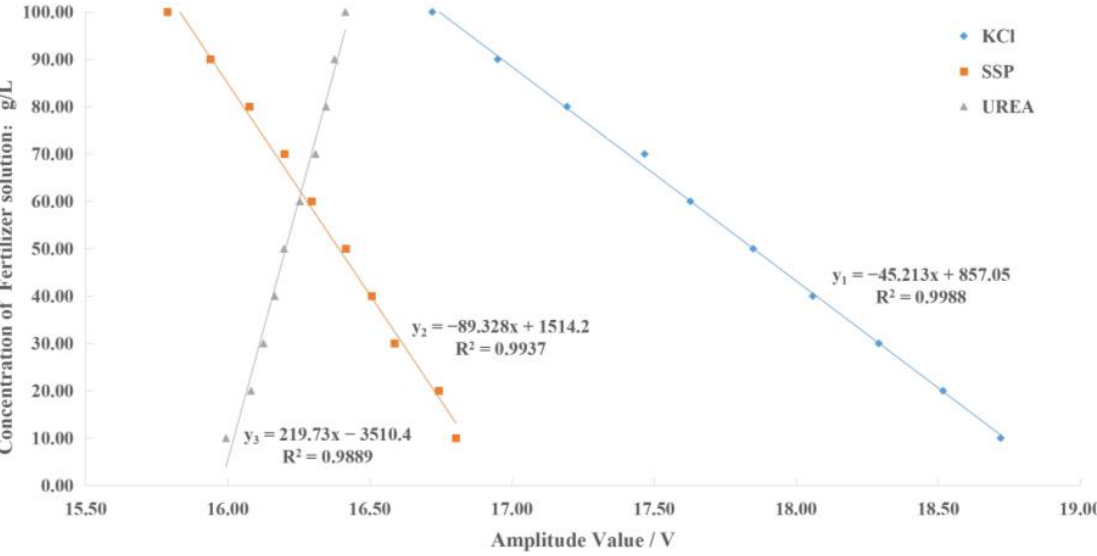
Figure 13. The relationship between fertilizer solution concentration and amplitude.